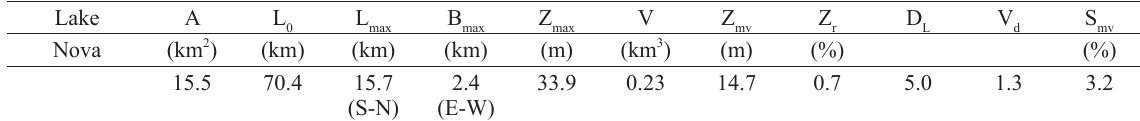
Lake Nova size and form